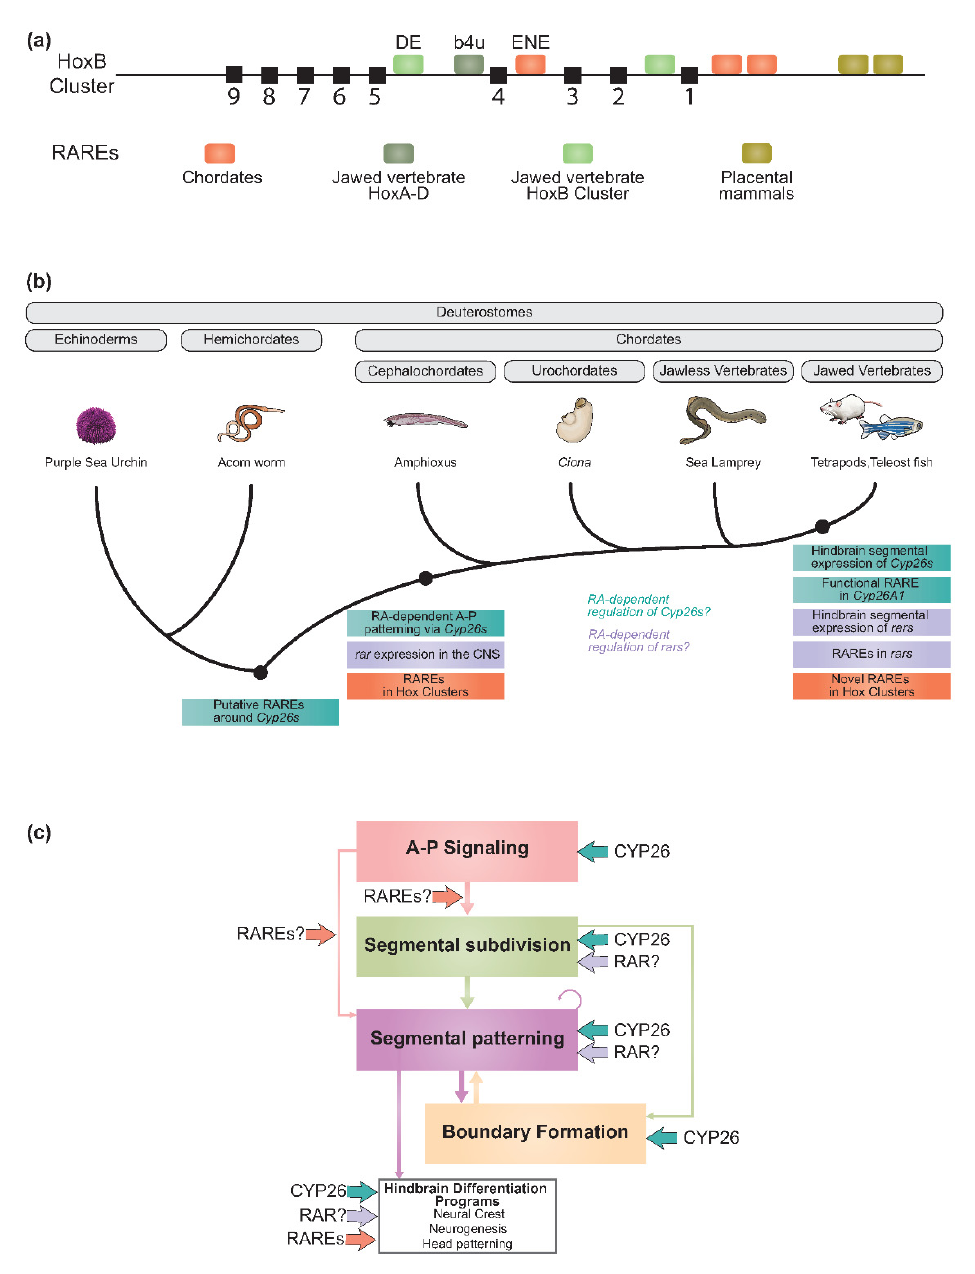
Figure 6. Diversification of the RA machinery and evolution of the vertebrate hindbrain GRN. ( a ) Evolving roles of RAREs in Hox clusters. Schematic illustrating different ways RAREs can evolve using the context of the mammalian HoxB cluster. Black boxes represent HoxB genes ( HoxB1 – B9 ). RAREs are represented on the cluster and color coded in accordance with their known evolutionary history. ( b ) Schematic phylogenetic tree summarizing important evolutionary changes in the regulation of major components of the RA machinery, represented in colored boxes, in accordance with the color code used in Figures 2 and 5. Important remaining evolutionary questions are indicated. Cartoons of different model organisms are adapted from [34]. ( c ) Diagram summarizing known inputs from different components of the vertebrate RA machinery on different modules of vertebrate hindbrain GRN (colored arrows) in addition to further possible ways other components of the RA machinery could have influenced and contributed to the elaboration of this GRN (colored arrows-question mark). The shared aspect of their expression is illustrated by an initial deployment at